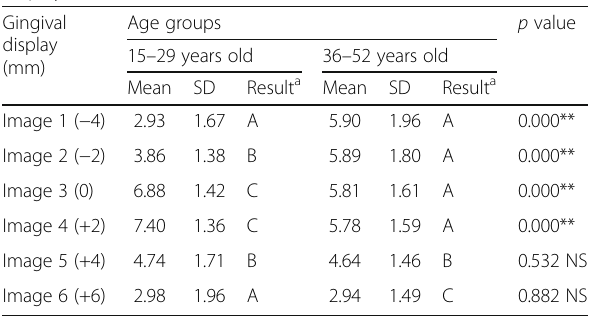
Table 3 Photograph ratings by age group of altered gingival display Gingival display